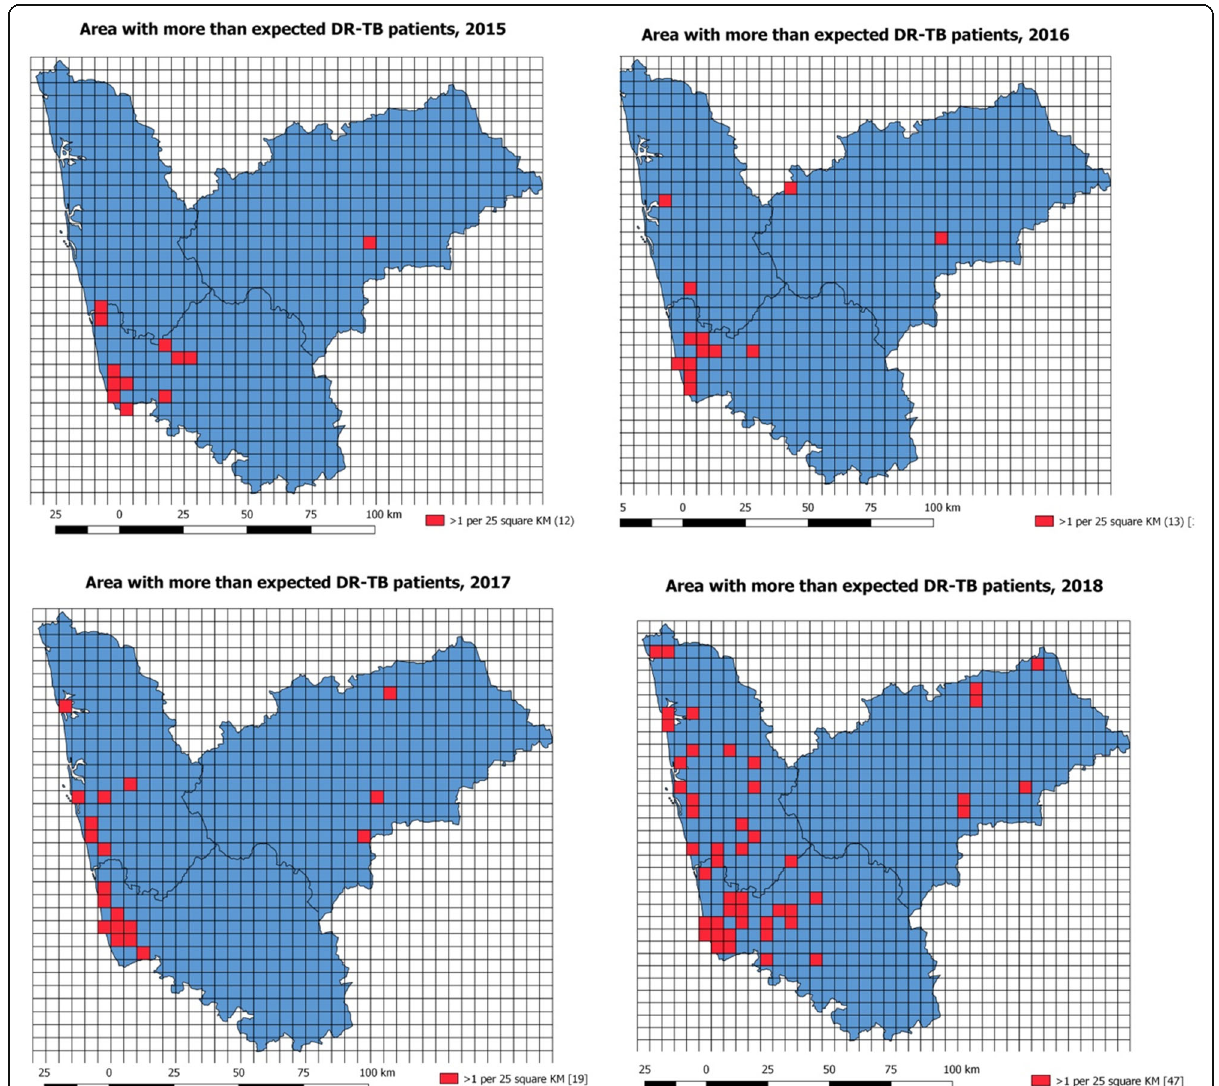
Fig. 4 Map depicting the grids (25 km 2 ) with more than the expected number of DR-TB